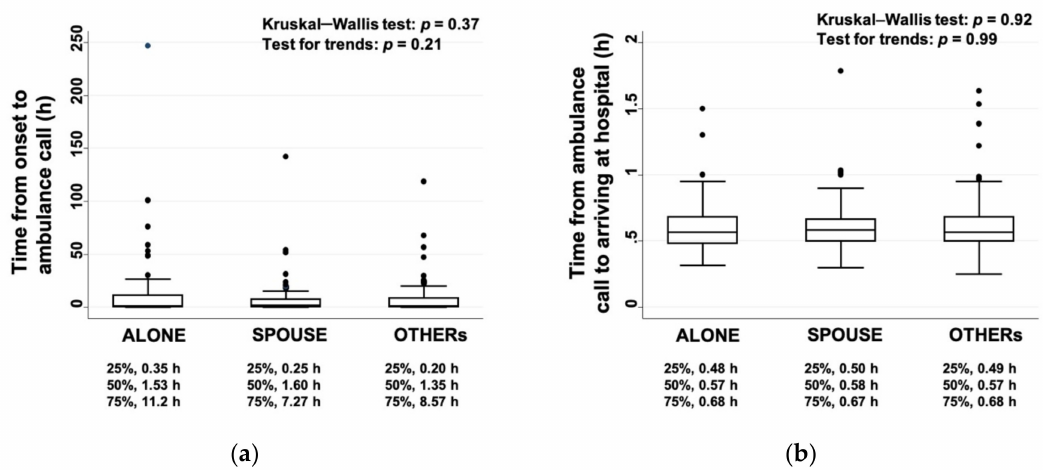
Figure 2. Cohabiting family members and the time from stroke onset to hospital admission: ( a ) time from the onset to the ambulance call and ( b ) time from the ambulance call to arriving at the